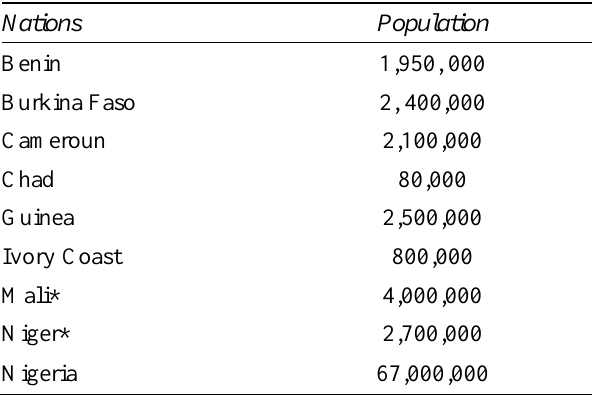
Table 2.2: Population of Nations along the Basin - The population distribution of the River Niger